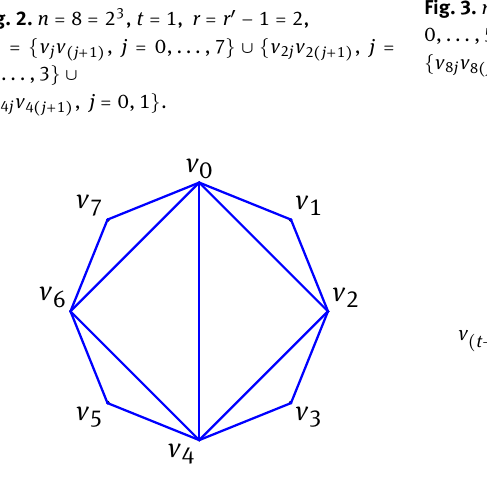
Fig. 4. n = 164 , t = 41 , r = 2 , α = 13 , and β = 14 . Fig. 5. n = 152 , t = 19 , r = 3 , α = 6 , and β = 7